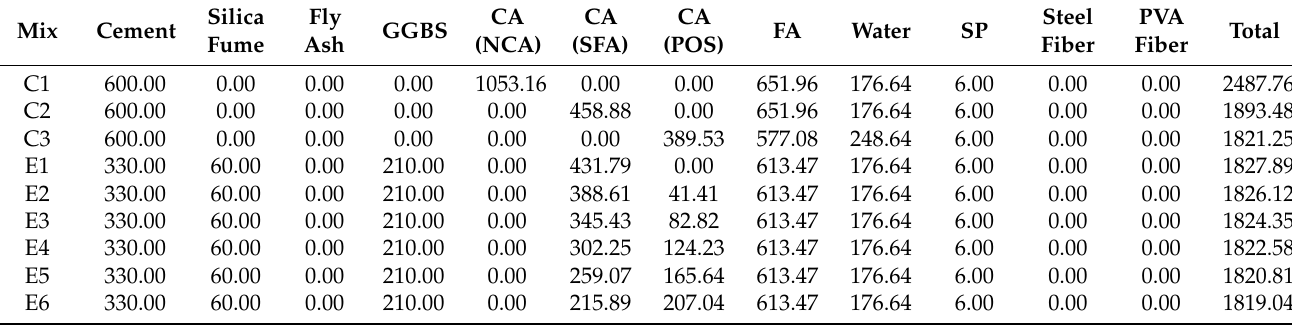
Table 3. Mix design of normal and lightweight concrete (kg/m 3